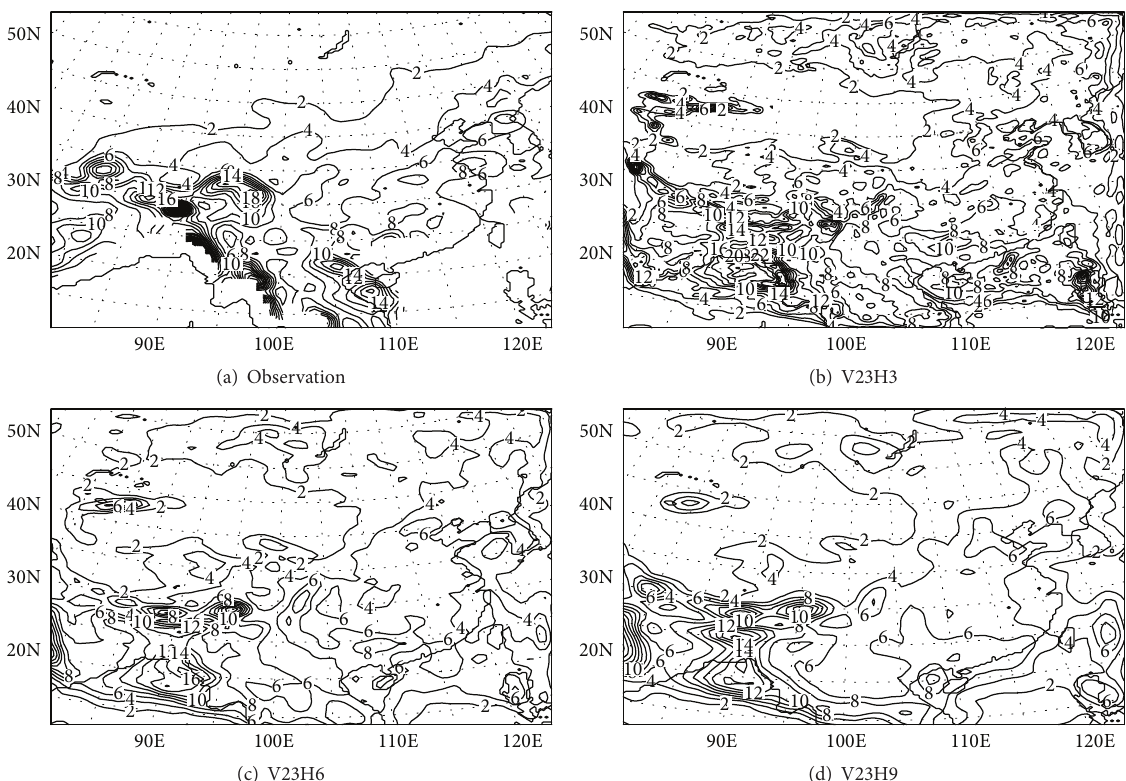
Figure 7: Summer-mean precipitation distribution from observations and Scheme V23 for (a) observations, (b) H3, (c) H6, and (d) H9 in mmd −1 .